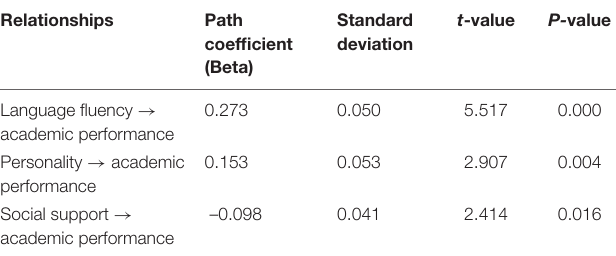
TABLE 6 | Direct effects of the antecedent variables of students’ academic performance.